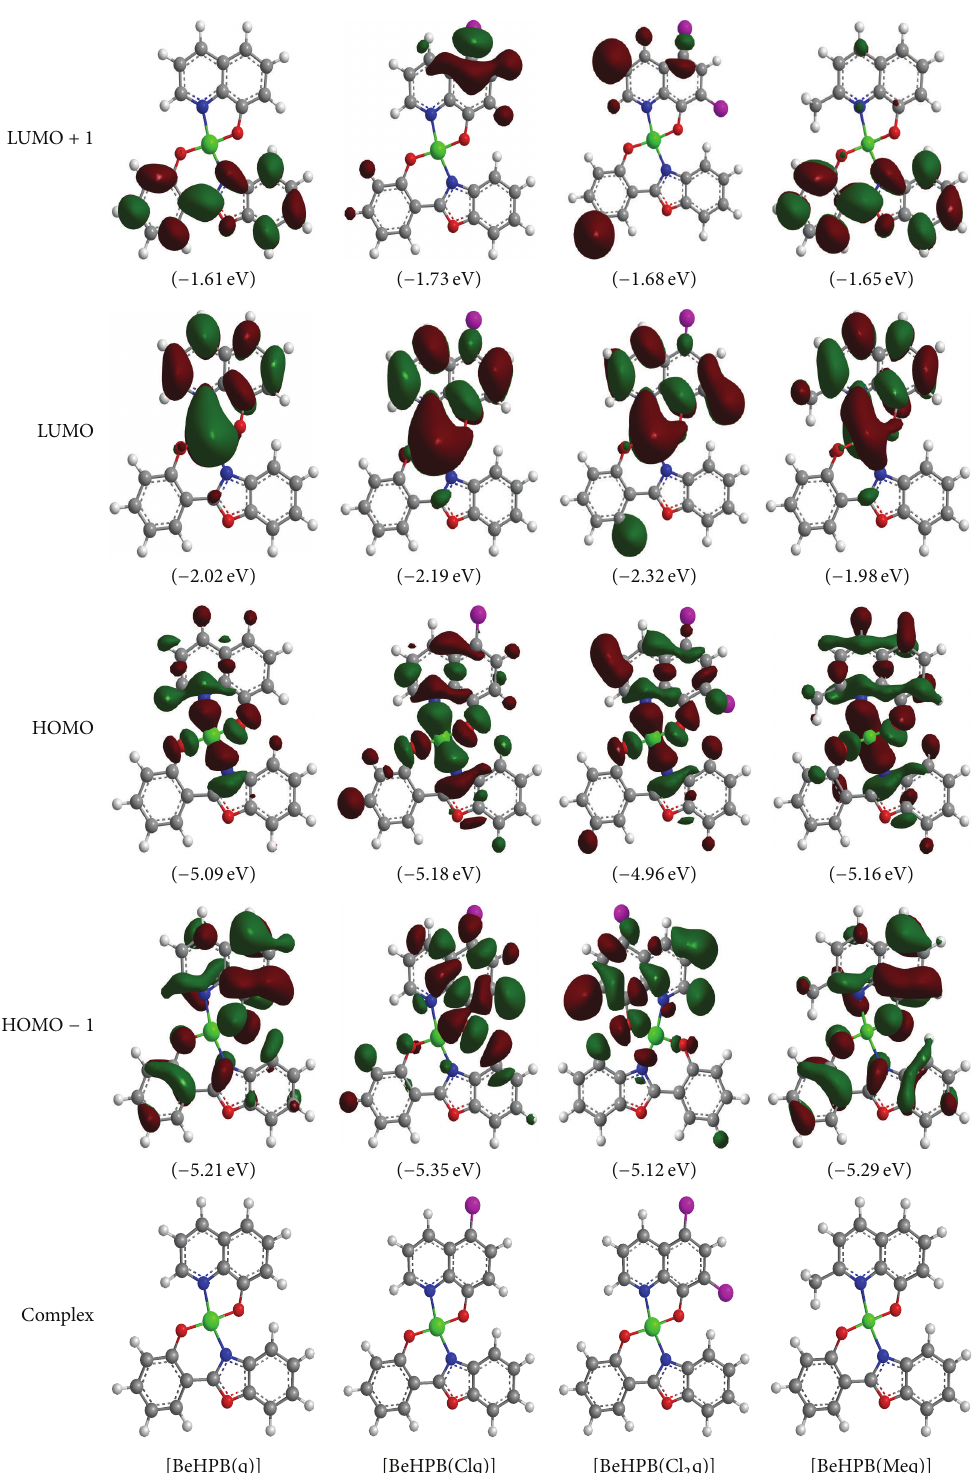
Figure 8: Optimized 3D molecular geometry, molecular orbital surfaces (0.05 eau −3 ),and energies (in parenthesis, eV) of theselected frontier molecular orbitals of beryllium(II)